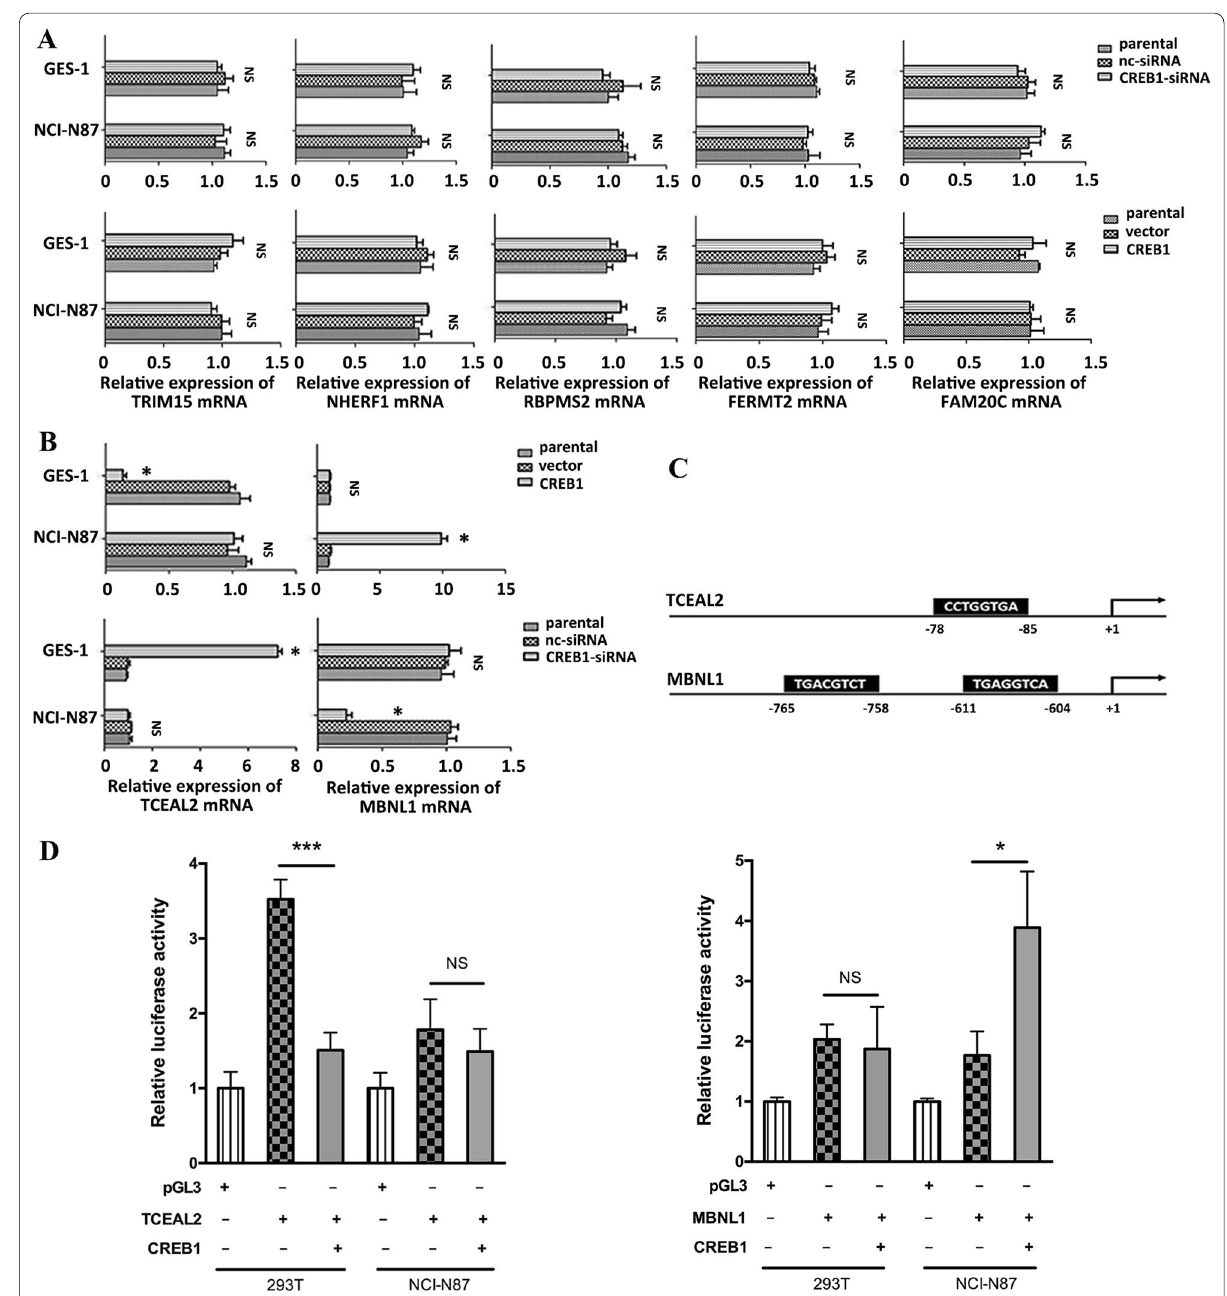
Fig. 3 Validation of differentially regulated targets of CREB1 between normal and cancer. A TRIM15, NHERF1, RBPMS2, FERMT2 and FAM20C, each gene expression was measured by qRT‑PCR in GES‑1 and NCI‑N87 cells transfected with CREB1 specific siRNA or CREB1 lentivirus (n B Overexpression or downregulation of CREB1 in GES‑1 and NCI‑N87 cells, and the expression changes of TCEAL2 and MBNL1 were measured by qRT‑PCR (n 3–4). C CREs in the promoters of TCEAL2 and MBNL1. Sequence analysis of the promoters of the two genes indicated the potential = binding sites for CREB1. D TCEAL2 or MBNL1 pGL3 luciferase reporter was co‑transfected with CREB1 into 293 T cells and NCI‑N87 cells, and relative luciferase activity was detected. *Means significant P ‑value < 0.05, *** means significant P ‑value < 0.001, NS means no significant, two‑sided Student’s t